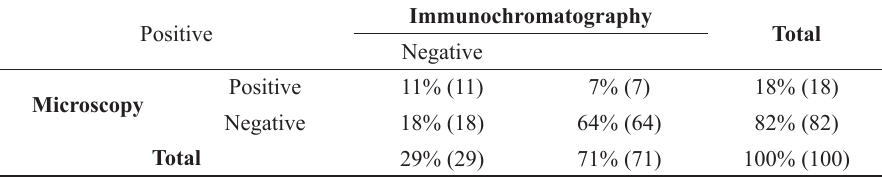
Comparison of relative (%) and absolute frequencies of microscopy and modified immunochromatography results for Giardia duodenalis